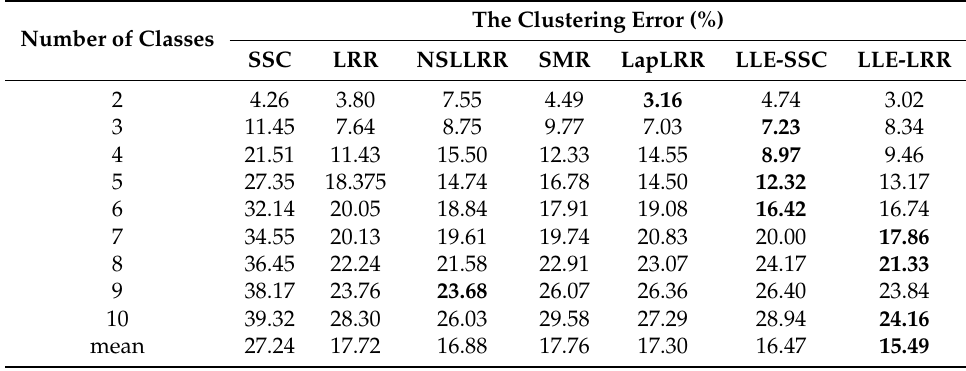
Table 4. Clustering results on USPS dataset. The clustering errors for 2,3,4,5,6,7,8,9,10 classes and their mean error are shown here. The best results are in bold font.